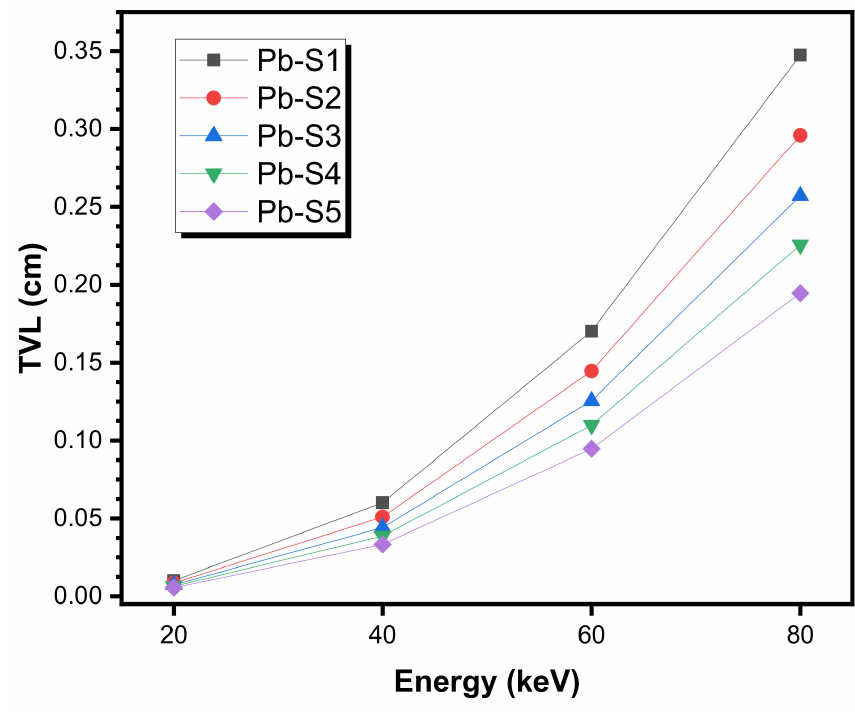
Figure 8. The TVL for the Pb-SX glasses at four energies (20, 40, 60 and 80